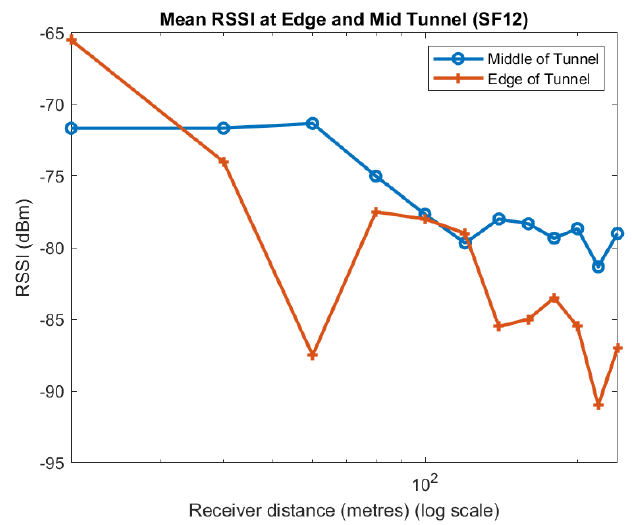
Figure 11. Effect of position in tunnel on RSSI: